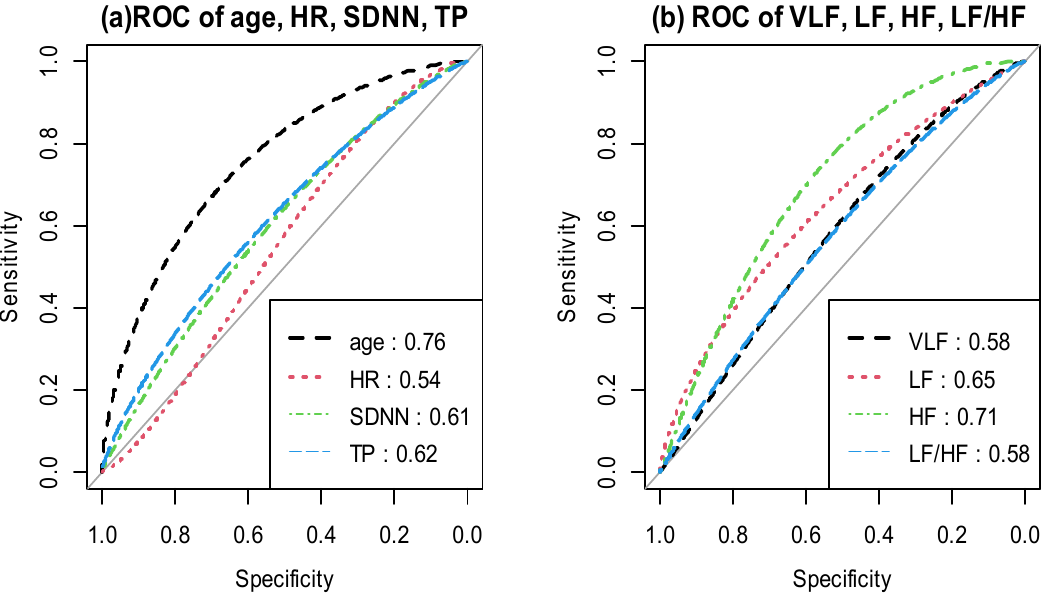
Figure 2. ( a ) ROC curve for HRV parameters (Age: dashed line with an AUC of 0.76; Heart rate (HR): dotted line with an AUC of 0.54; Standard deviation of the NN interval (SDNN): dot-dashed line with an AUC of 0.61; Total power (TP): long- dashed line with an AUC of 0.62. ( b ) ROC curve for HRV parameters (very low frequency (VLF): dashed line with an AUC of 0.58; low frequency (LF): dotted line with an AUC of 0.65; high frequency (HF): dot-dashed line with an AUC of 0.71; LF/HF: long-dashed line with an AUC of 0.58).